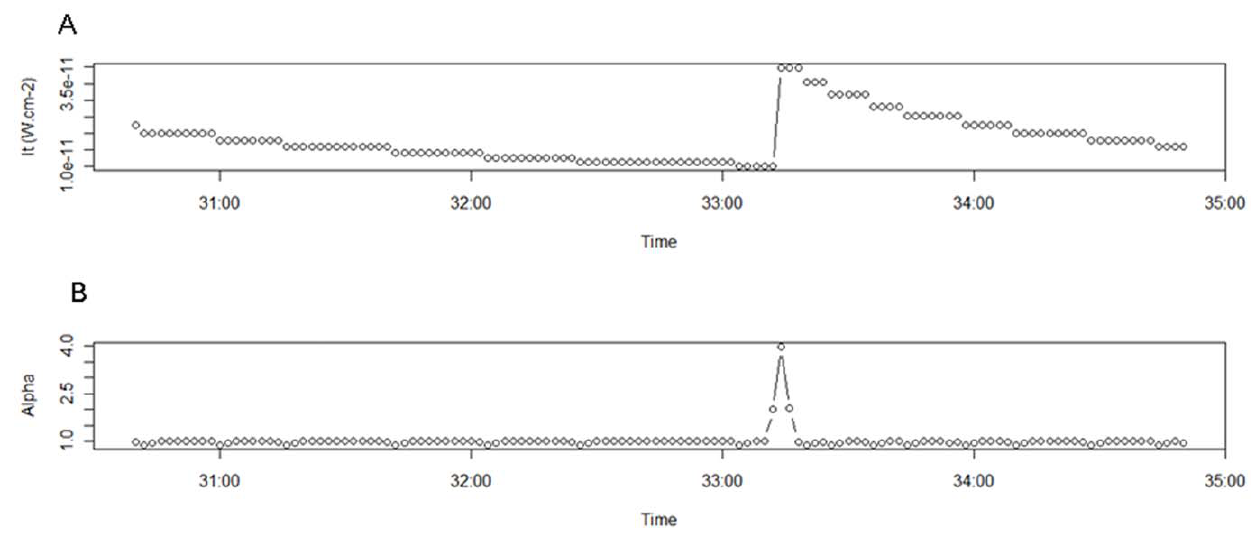
Figure 3. Light profile of a bioluminescence events and the a (t) profile. A. The light profile of one bioluminescence event. B. The a (t) profile of this bioluminescence event. a (t) is greater 1 during the increasing light phase of a bioluminescence event.